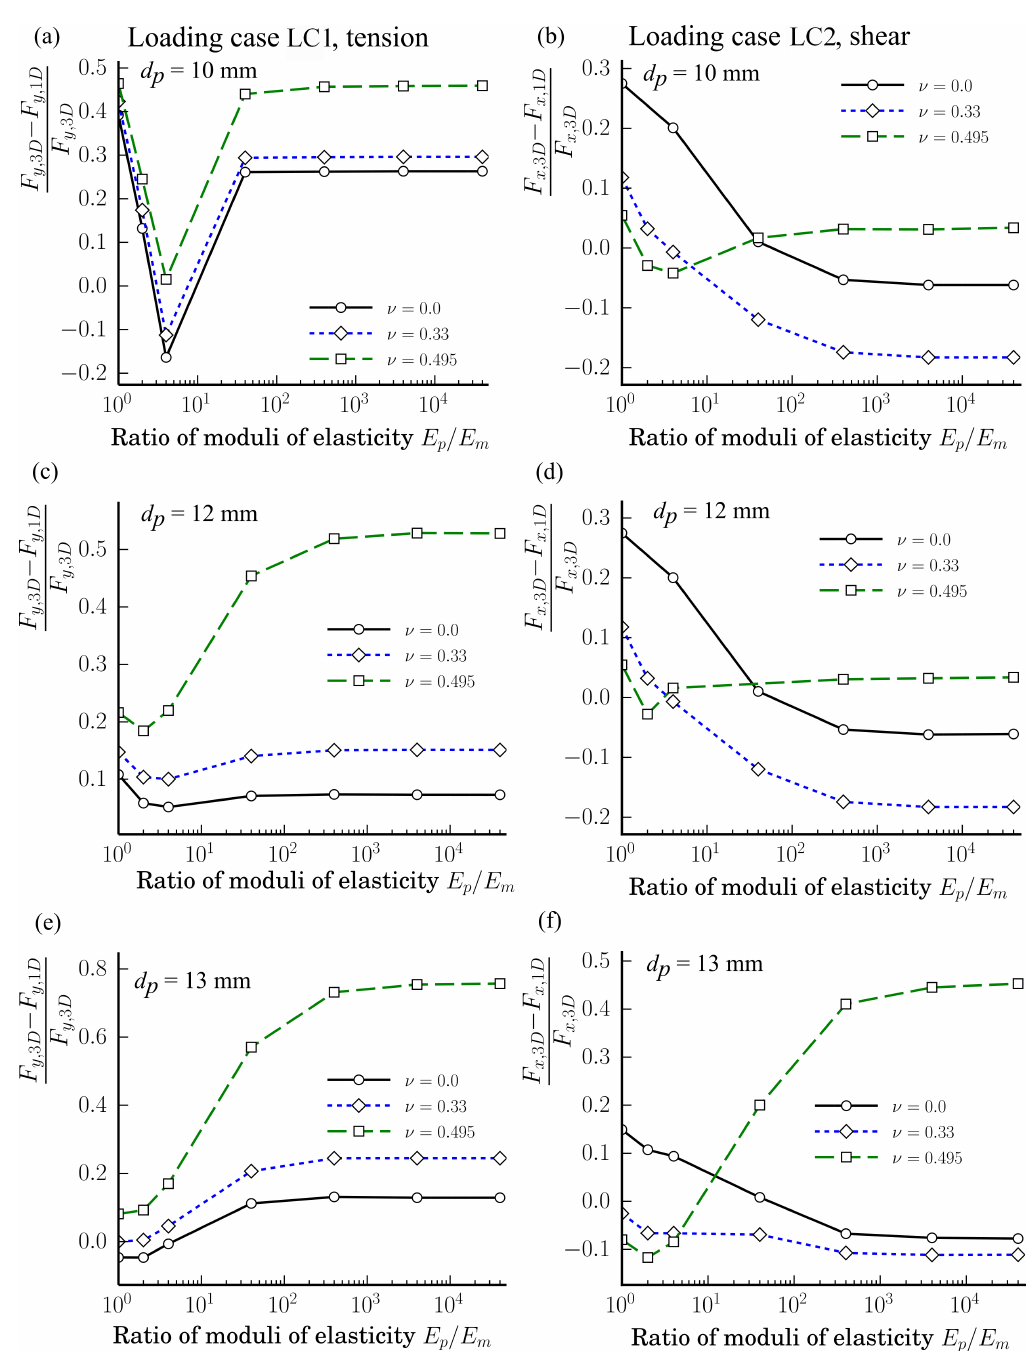
Figure 10. Dependences of the relative ratios ( F y ,3 D − F y ,1 D ) / F y ,3 D and ( F x ,3 D − F x ,1 D ) / F x ,3 D of the axial and shear forces of loading cases LC1 and LC2 on the ratio E p / E m at different Poisson’s rations ν p ∈ { 0.0,0.33,0.495 } and particles diameters d p ∈ { 13,12,10 } mm: ( a , b ) as d p = 13 mm; ( c , d ) as d p = 12 mm; ( e , f ) as d p = 10